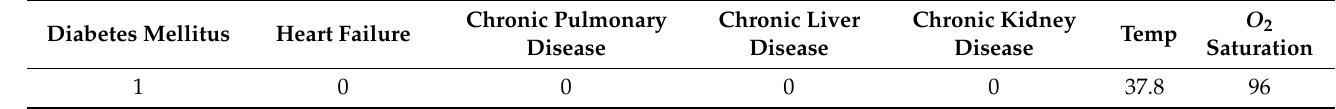
Figure 1. A depiction of the proposed method. Table 2. Patient’s comorbidities.